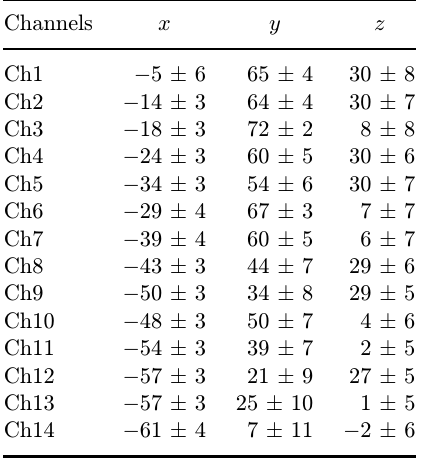
Table 1. The mean MNI coordinates for all the 14 channels across all subjects.